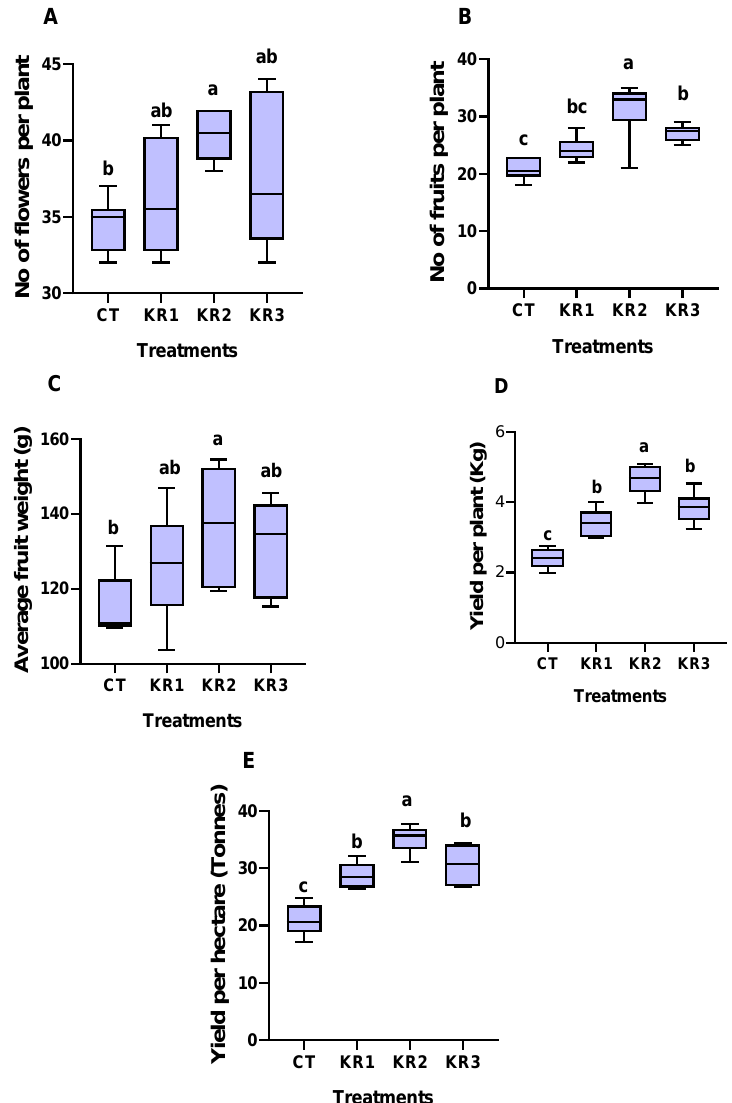
Figure 4. Yield parameters of tomato plants treated with Kendal Root biostimulant: ( A ) Number of flowers per plant; ( B ) number of fruits per plant; ( C ) average fruit weight; ( D ) yield per plant; and ( E ) yield per hectare. Data in the figure are expressed as mean ± SE. Mean values followed by the same letter do not differ significantly at p ≤ 0.05 by DMRT.